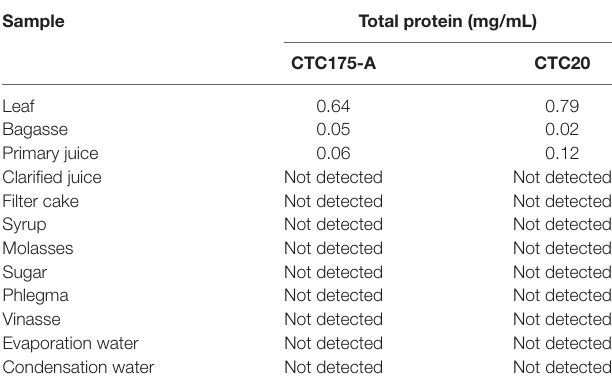
TaBle 11 | Presence ( + ) and absence ( − ) of Cry1ab protein in fractions samples from the industrial processing of CTC20 and CTC 175-A Varieties, using ELISA